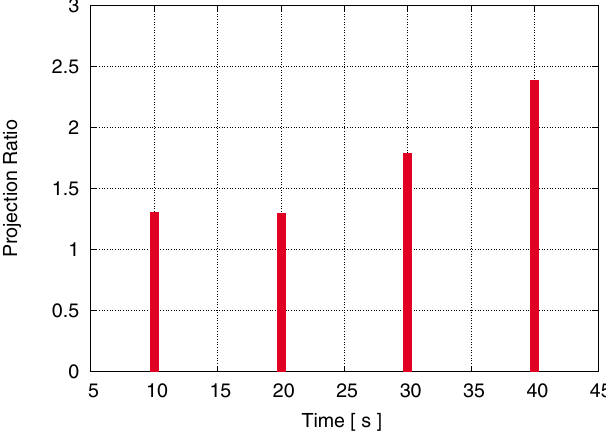
FIG. 7. (Color) Projection ratios on ramp with constant skew quadrupole current